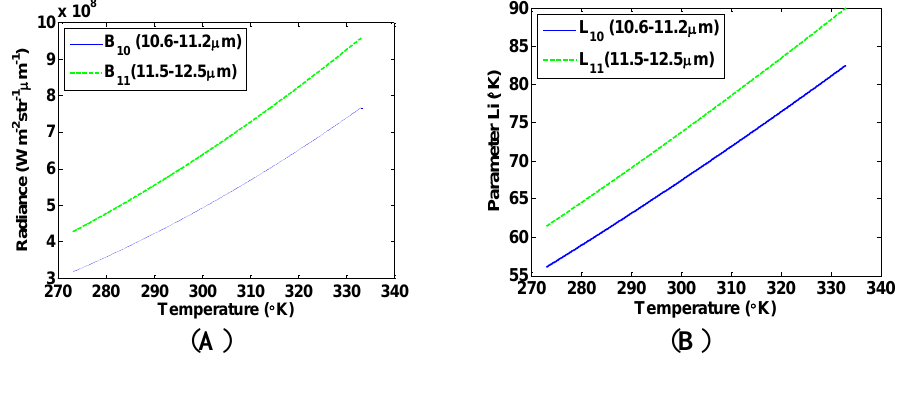
Figure 2. Variations of ( A ) Planck’s radiance and ( B ) L each of the TIRS